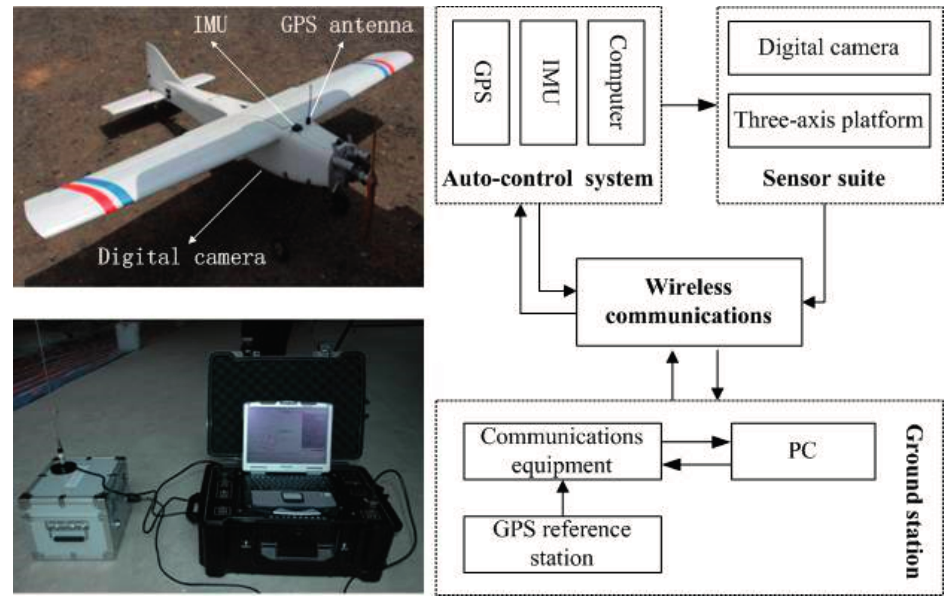
Figure 2. The UAV system used in the